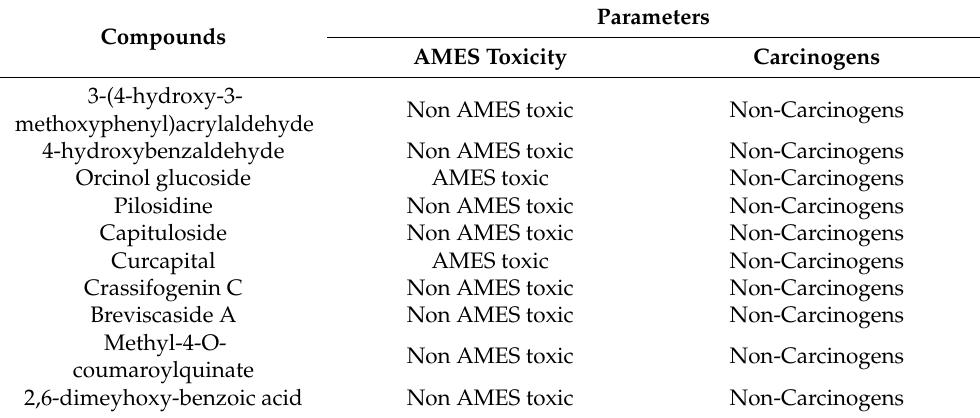
Table 6. Toxicological property predications of the major selected bioactive compounds of M. capitulata using admetSAR online server.